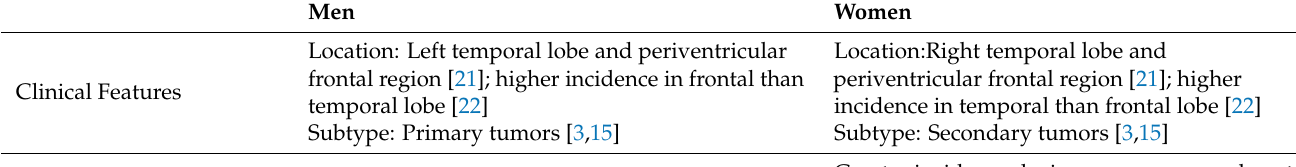
Table 1. Sex Differences in